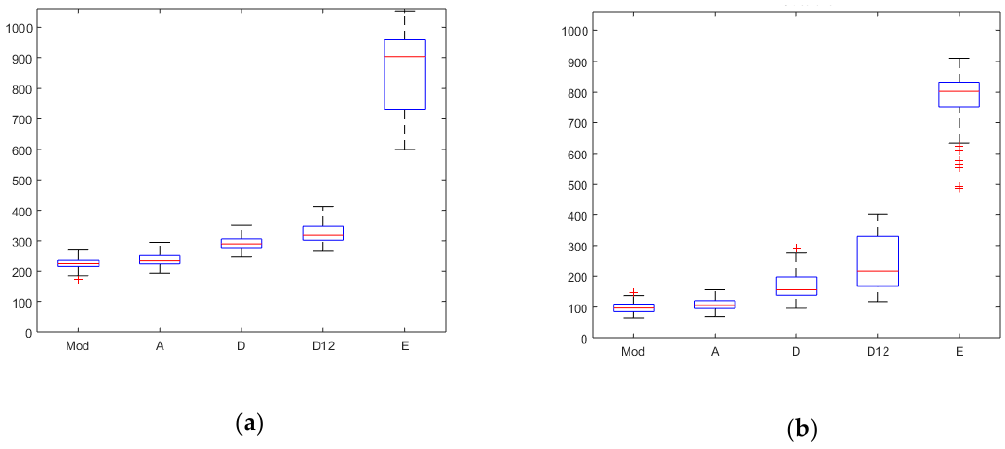
Figure 8. Lifetime of dredging scenarios when operations are performed in ( a ) April and ( b ) October.